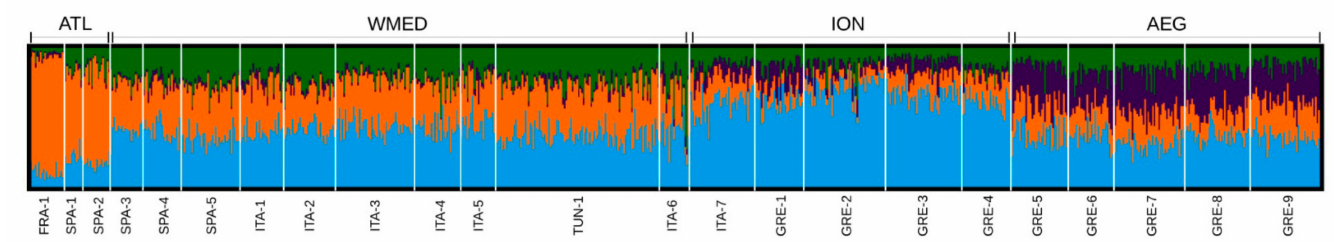
Figure 1. Structure clustering analysis of the wild populations. Results for the most likely number of clusters (k = 4). Labels under the graph indicate the sample groups. Labels above the graph indicate the genetic clusters suggested by the analysis (reproduced with permission from